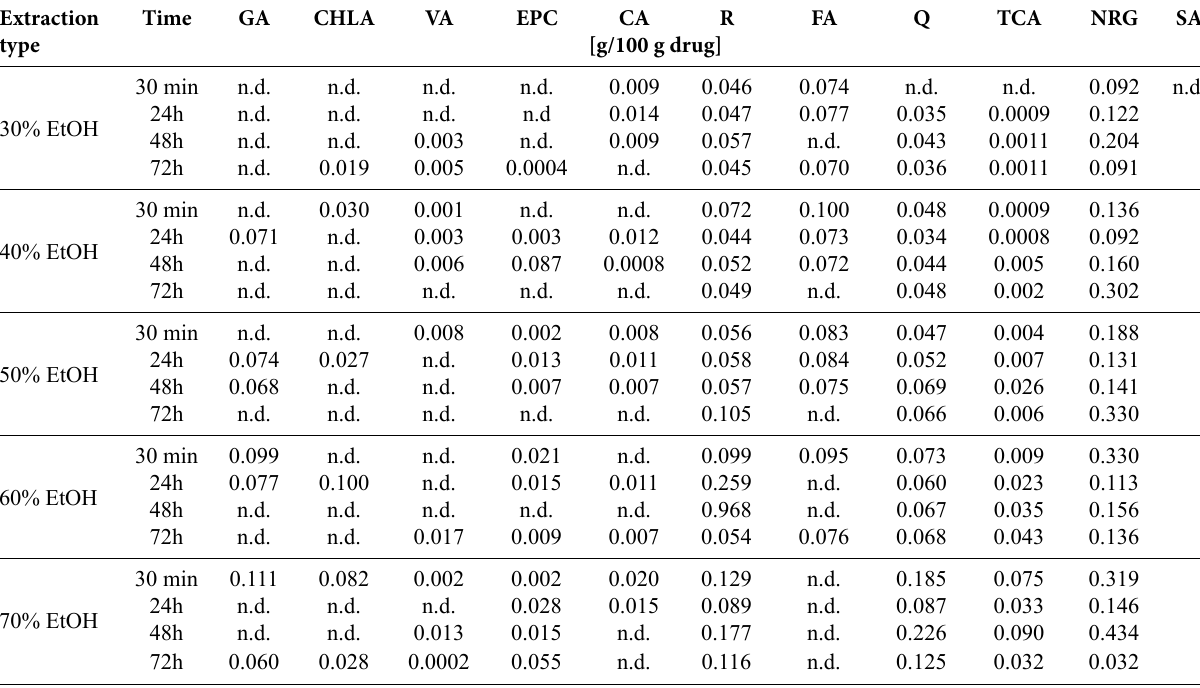
Table 5. Chemical composition of Salix caprea leaves extracts Extraction Time type